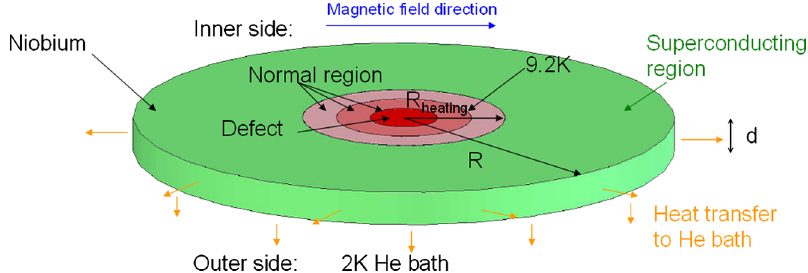
niobium.FIG. 4. Dynamic model for cavity quench